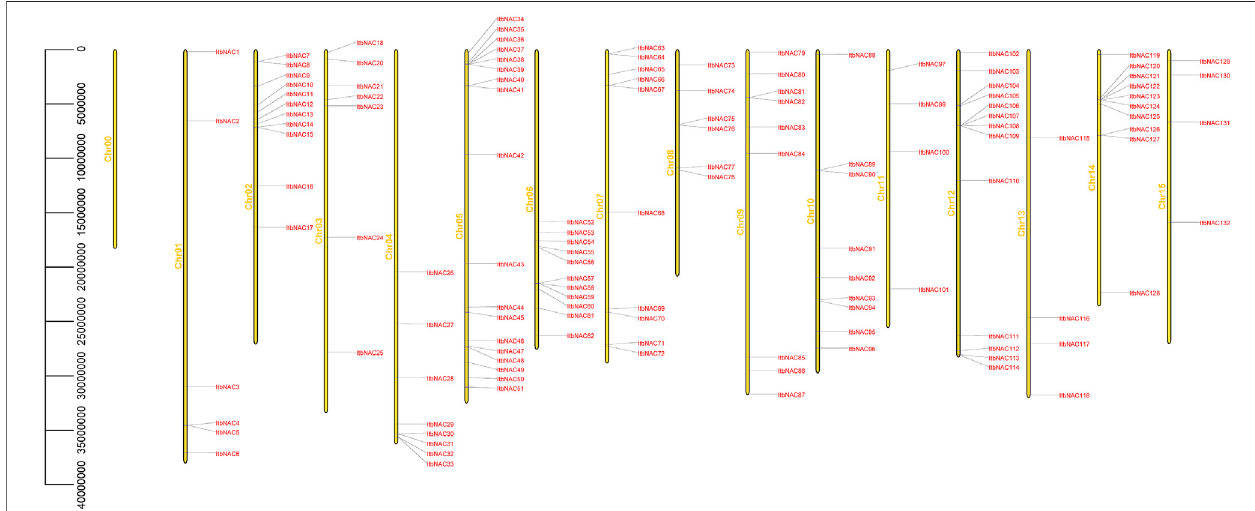
FIGURE 2 | Chromosomal location of ItbNAC genes. Yellow bars on the left side represent chromosomes, and gene ID on the right side represents its location mapped on the chromosome. 130 ItaNAC genes were unevenly distributed throughout 15 Ipomoea triloba chromosomes.